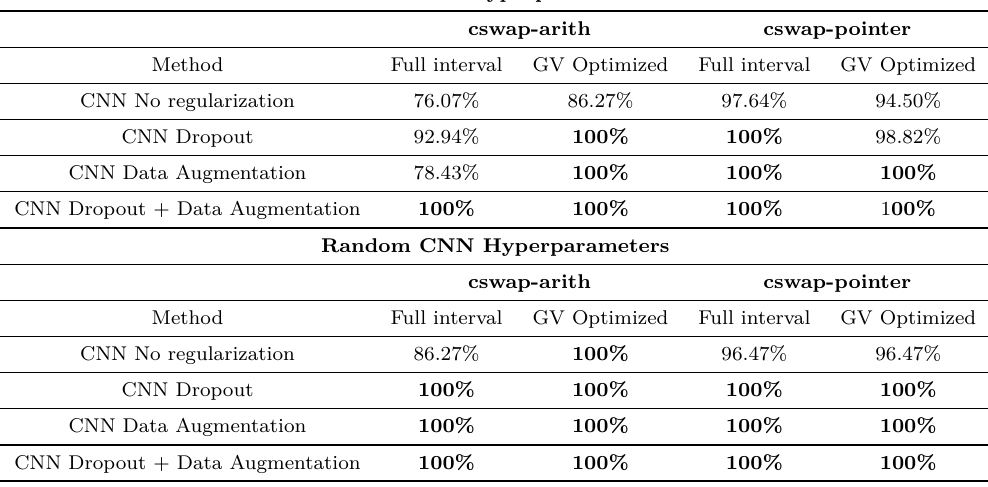
Table 5: Summary of iterative framework results: maximum single trace accuracy achieved from ten framework executions. Results for the cswap-arith and cswap-pointer datasets for full sample intervals and after selecting an optimal interval gradient visualization (GV)